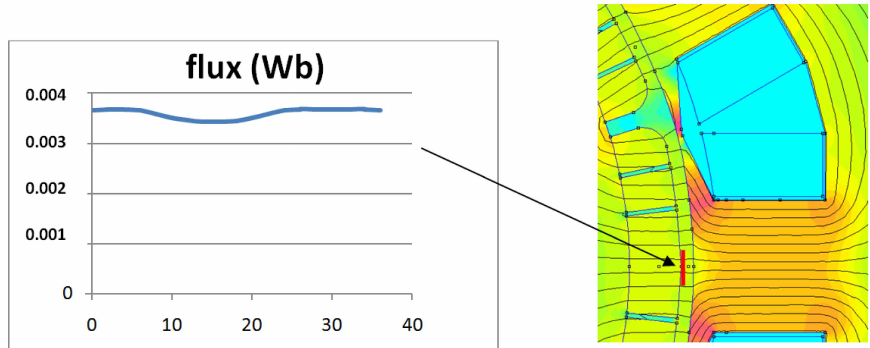
Figure 19. At no load, the rotor position is increasing step by step (0 ˝ to 36 ˝ ). For each position, the flux on one magnet surface is plotted. As the slots were closed, the slot depression mitigates the permeance variation and the flux remains nearly constant.